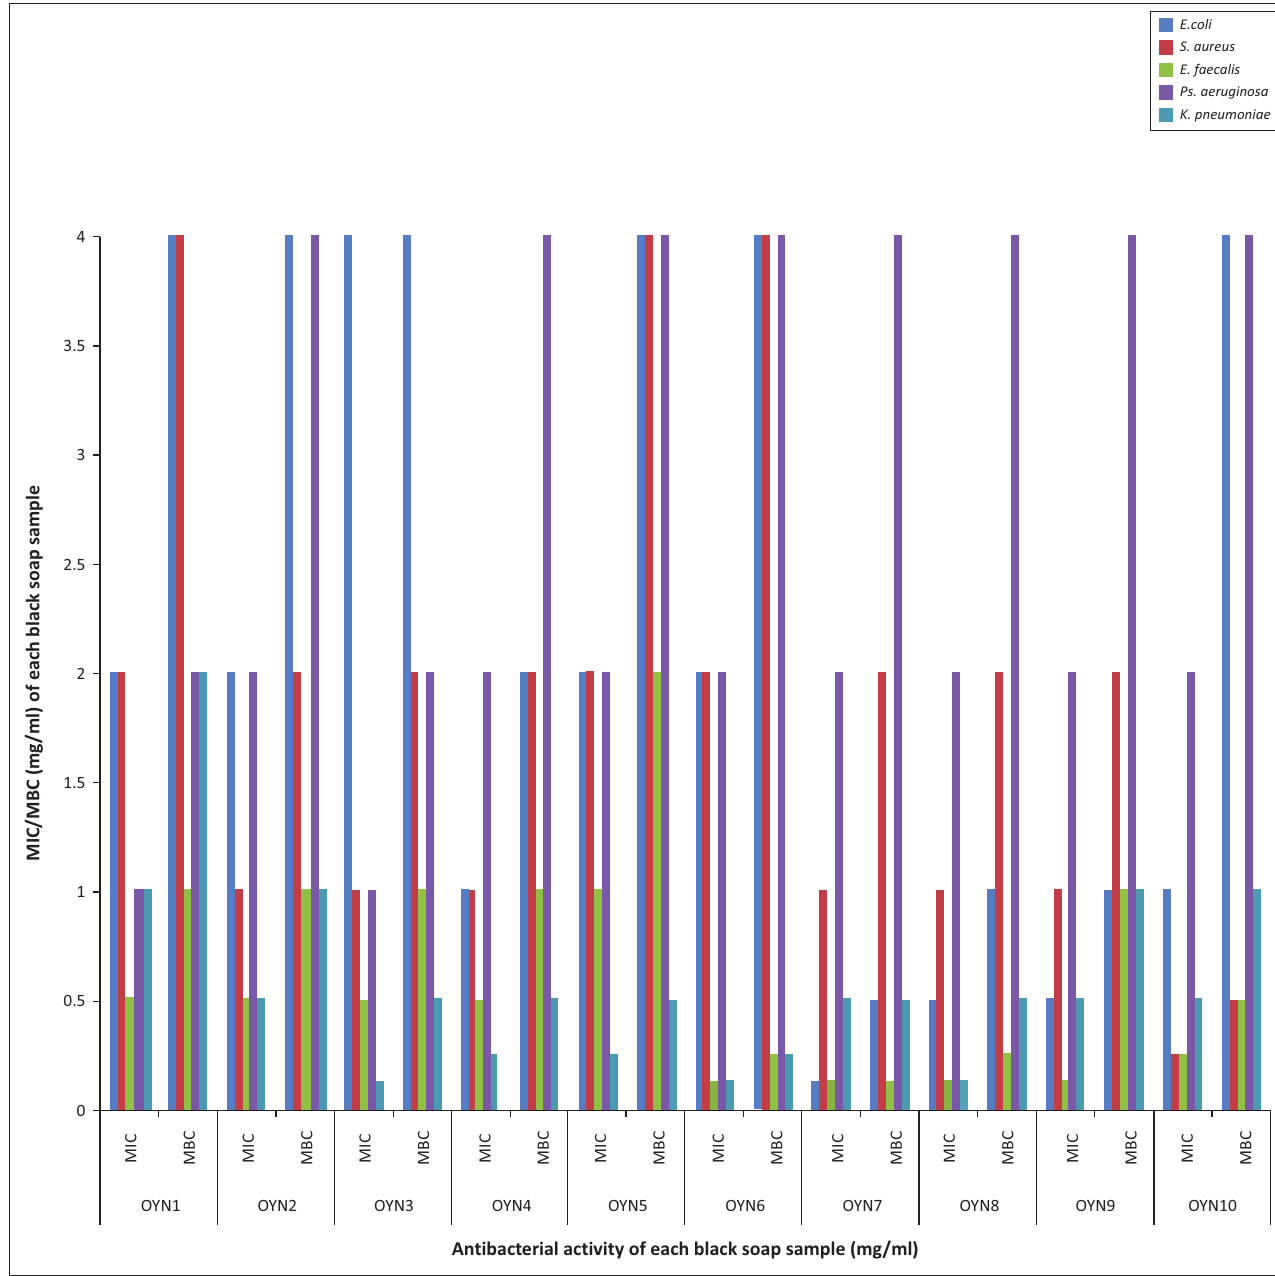
FIGURE 2: Composite bar chart showing the minimum inhibitory concentration and minimum bactericidal concentration of the different African black